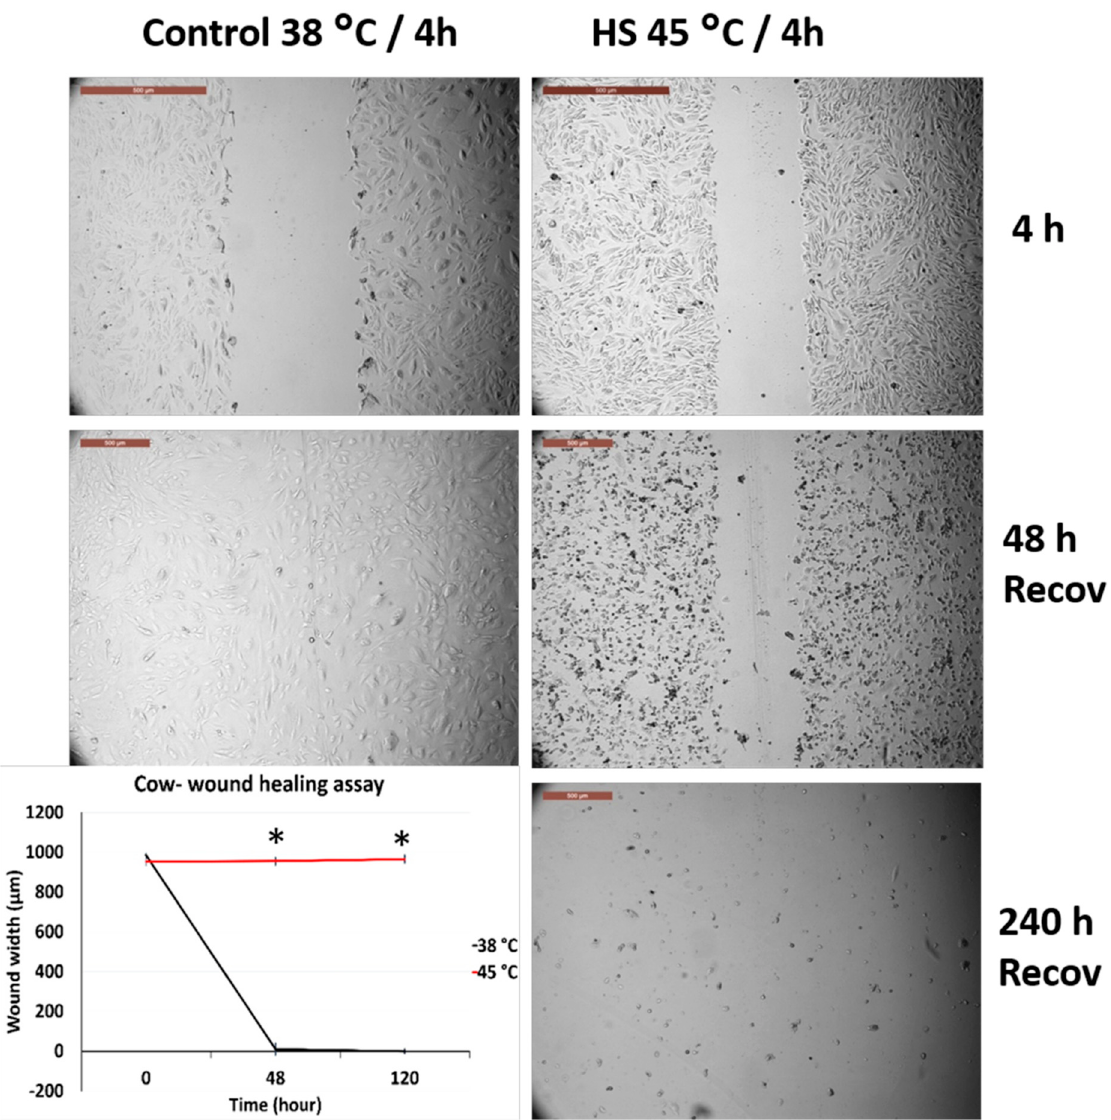
Figure 4. Wound healing (cell scratch) assay for cow primary cultured fibroblasts that recovered after exposure to 45 °C for 4 h and reached confluency as compared with the control cells (38 °C for 4 h). The wounds were created after cell recovery at confluency. Cells were incubated under the required conditions, recovered at 38 °C, and monitored daily for wound closure. Scale bar = 500 µm. Data are presented as means ± SEM, values of the same timings were analyzed using Student’s t -test, and asterisks (*) indicate significant differences at p < 0.05.